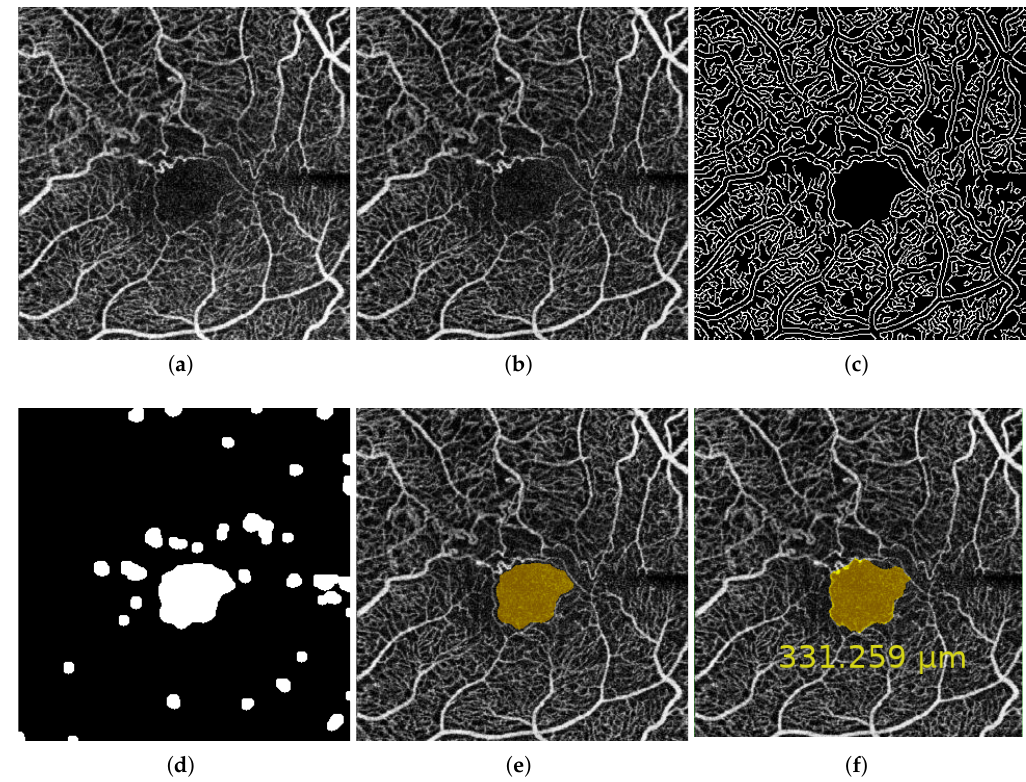
Figure 4. A representative example of the steps involved in obtaining the Foveal Avascular Zone (FAZ) segmentation. ( a ) Original image. ( b ) Enhanced image after applying a top-hat morphological operator. ( c ) Extracted edges from the enhanced image after applying an edge detector. ( d ) Obtained image after the application of morphological operators as opening and closing. ( e ) Result after removing small structures in ( d ) and the corresponding selection of the largest region. ( f ) Final result, obtained by the application of a region growing process over the selected region in ( e ) to improve the segmented FAZ region and calculate the final FAZ area, shown in µ m for more